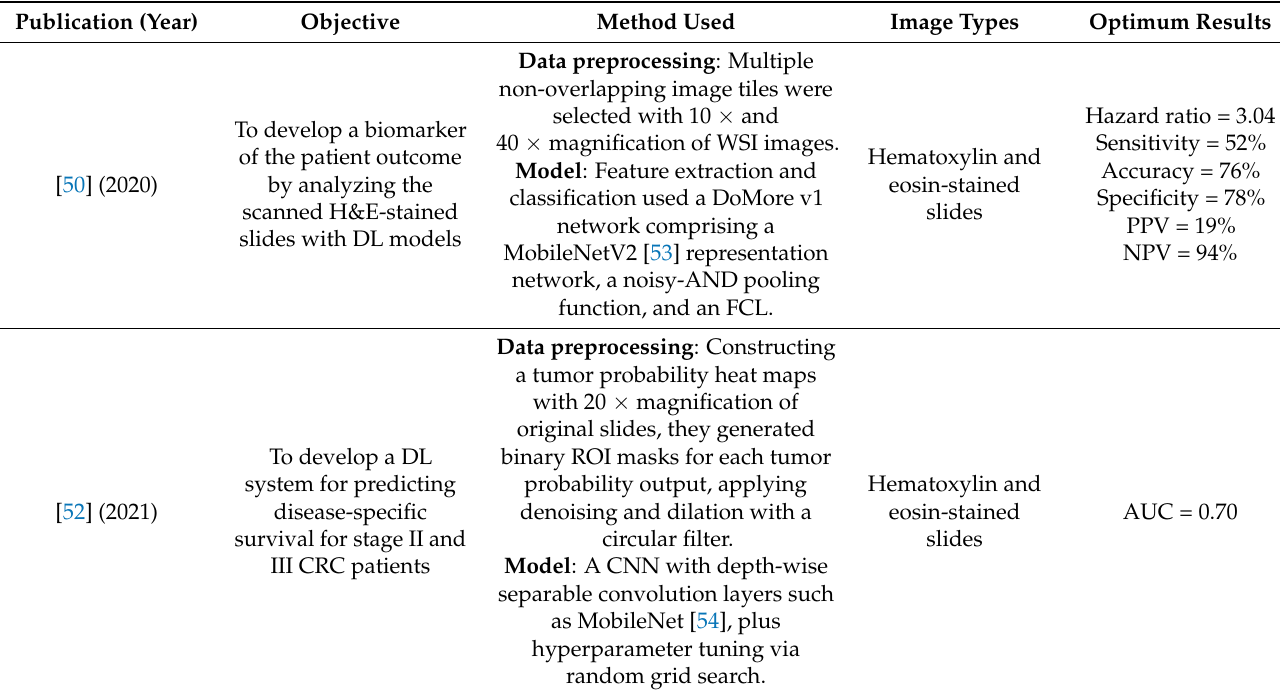
Table 3. Recently published articles on CRC tumor tissue detection and classification using DL